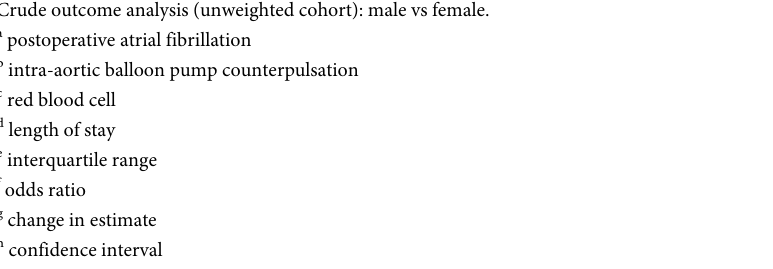
Crude outcome analysis (unweighted cohort): male vs female.